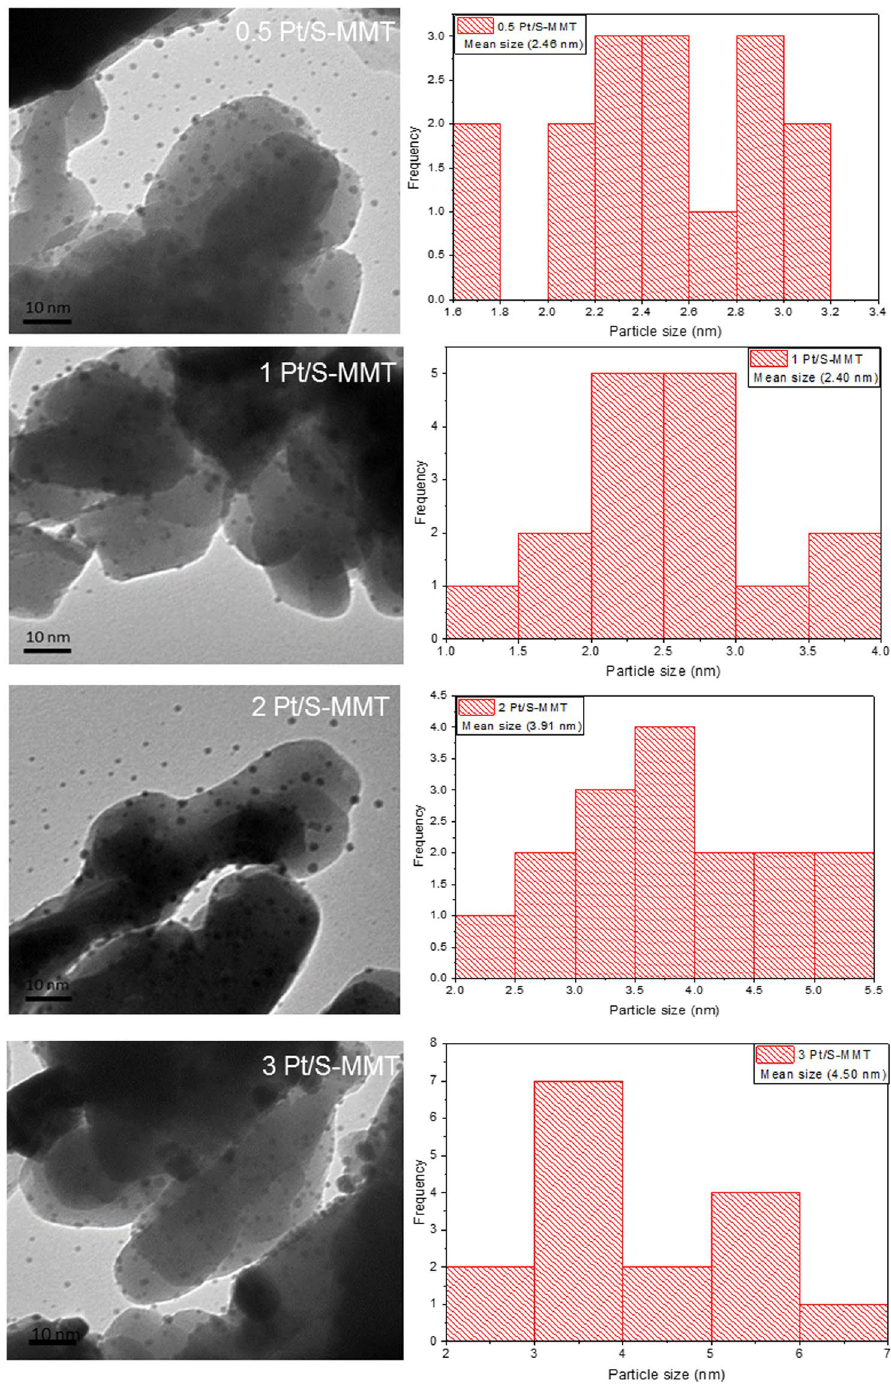
Figure 3. Transmission electron micrographs of different Pt/S-MMT